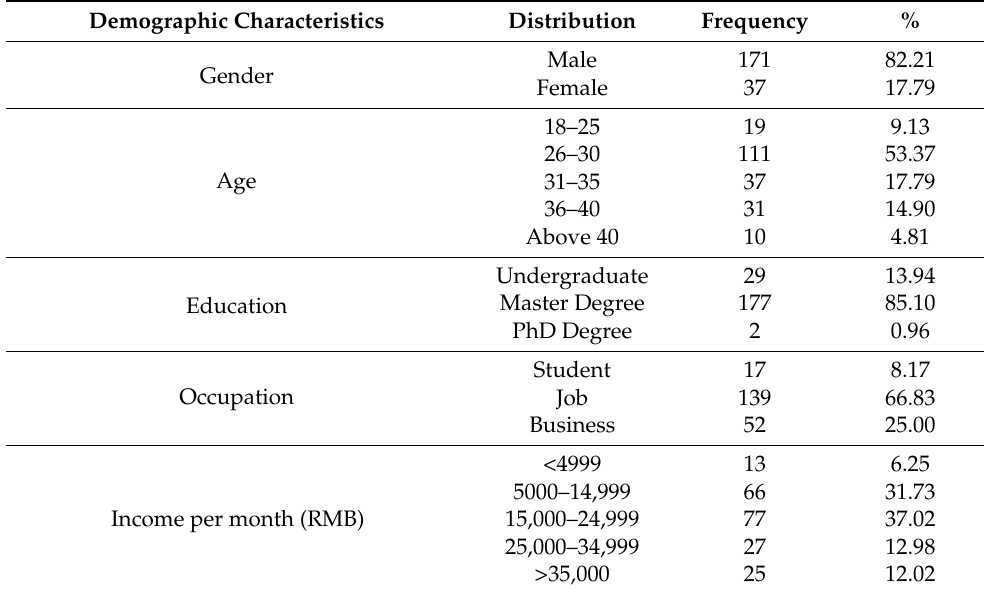
Table A1. Demographic Characteristics of Respondents, N =